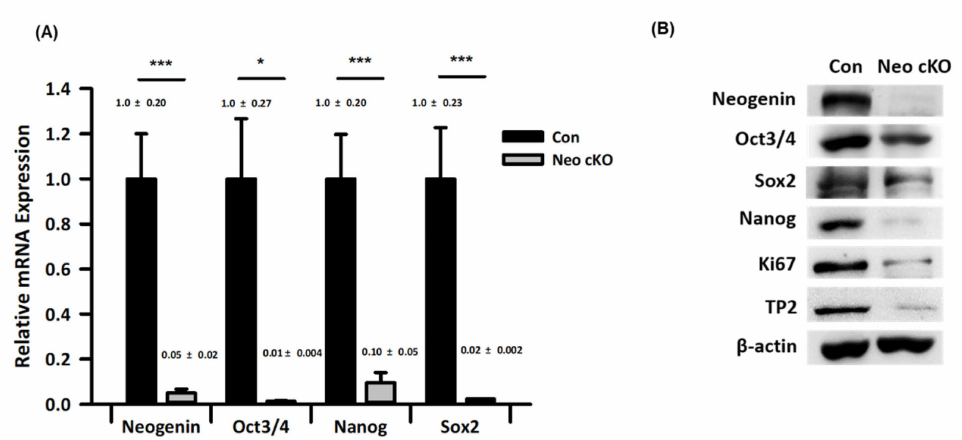
Figure 3. Expression profiling of spermatogonial stem cell markers in control and neogenin-cKO testes. Neogenin was conditionally knocked out in the mouse testis by CRISPR-Cas9 as described in the Materials and Methods. ( A ) Quantitative real-time PCR analysis of relative mRNA expression of neogenin, Oct3/4, Sox2, and Nanog normalized against that of β -actin. (n = 3) ( B ) Proteins extracted from testicular tissues at postnatal day 26 were analyzed by Western blotting. β -actin was used as a housekeeping protein. Con: control testis; Neo cKO: neogenin conditional knock-out testis. Data are the mean ± SD of triplicates. * p < 0.05 and *** p < 0.001 versus control by the Student’s t -test.